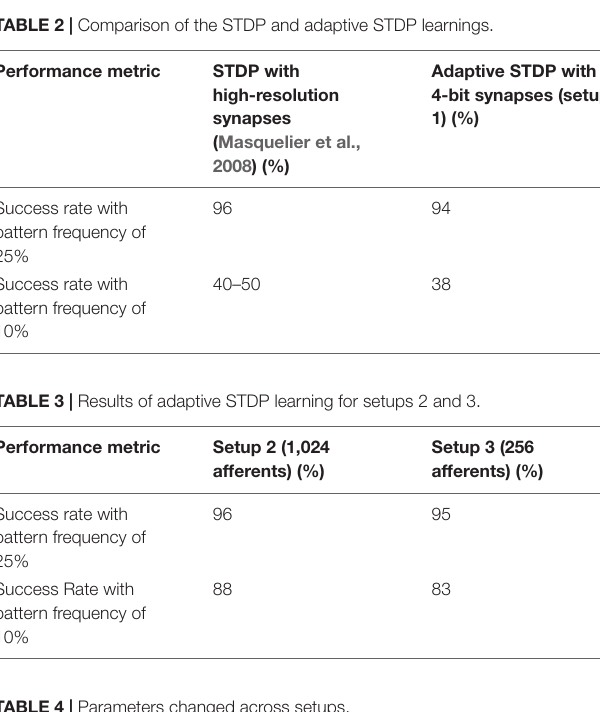
TABLE 4 | Parameters changed across